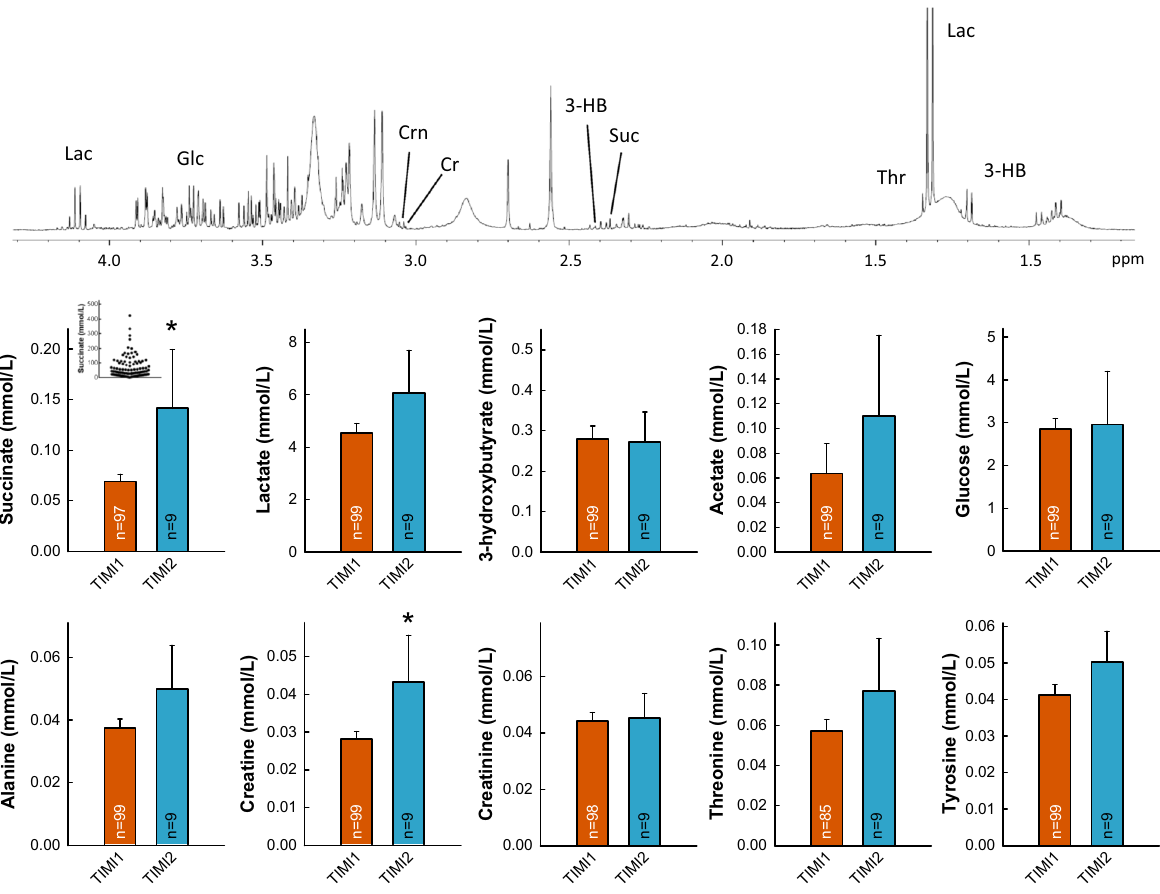
Figure 1. ( A ) Representative 1 H-NMR spectra obtained from plasma extracts in a STEMI patient included in the COMBAT-MI clinical trial. Abbreviations: 3-HB: 3-hydroxybutyrate; Cr: Creatine; Crn: Creatinine; Glc: Glucose; Lac: Lactate; Suc: Succinate; Thr: Threonine. ( B ) Concentrations of selected metabolites (mmol/L) analyzed by 1 H NMR spectroscopy in plasma extracts obtained from peripheral blood samples in STEMI patients with initial TIMI flow 1 as compared with data from those with initial TIMI flow 2. * ( p < 0.05) indicates significant differences vs. TIMI 1 group. Inset shows variability in succinate concentrations in control TIMI 1 patients (data in µmol/L).